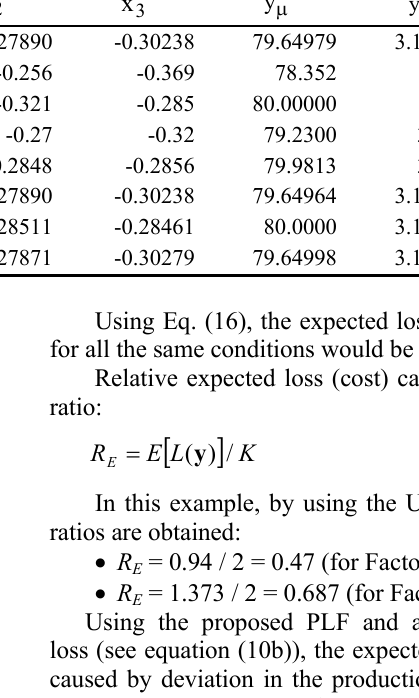
Table 4. Comparison of the optimal results obtained by different methods Approach 1